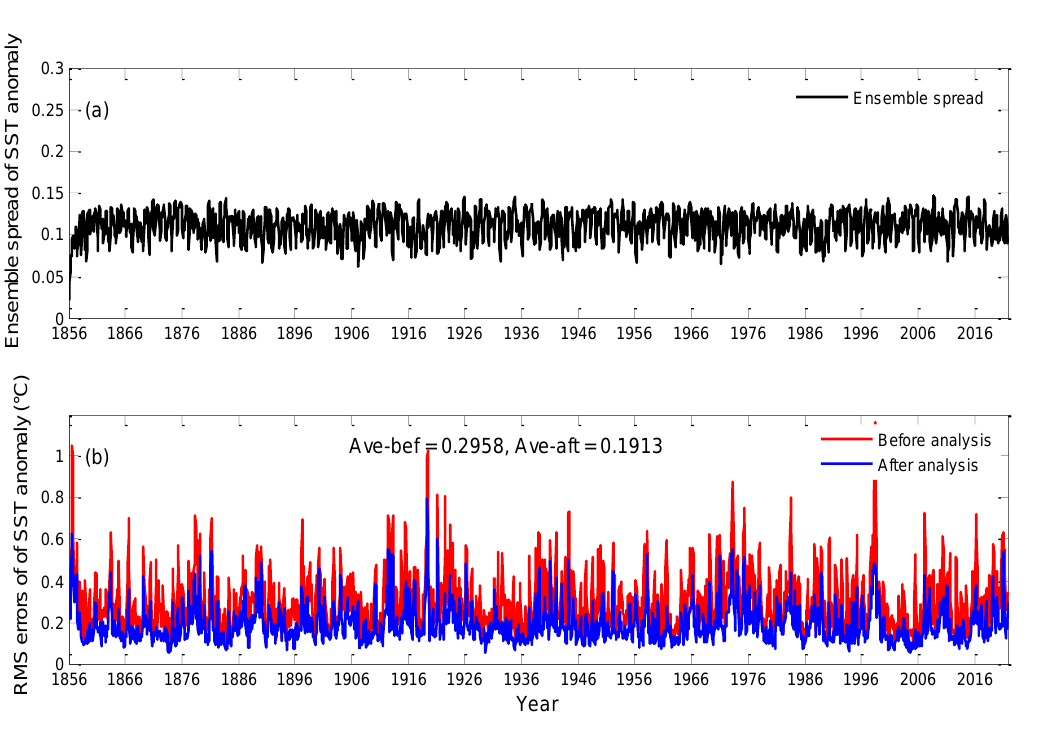
Figure 4. Time series of the ( a ) ensemble spread and ( b ) RMS errors of Niño3.4 SST anomalies before and after assimilation in EAKF_F-Assim.